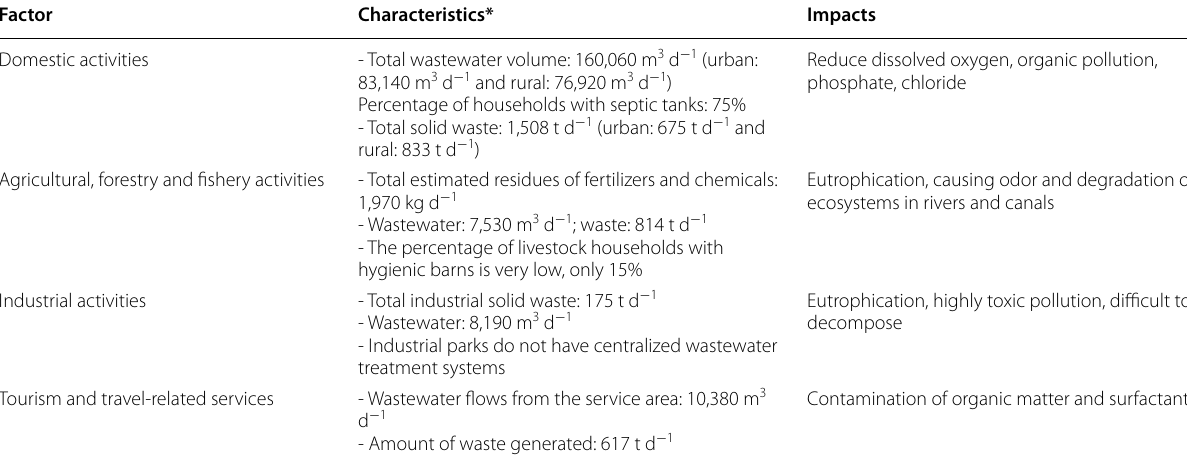
Table 3 The impacts of rapid socioeconomic development on surface water quality Factor